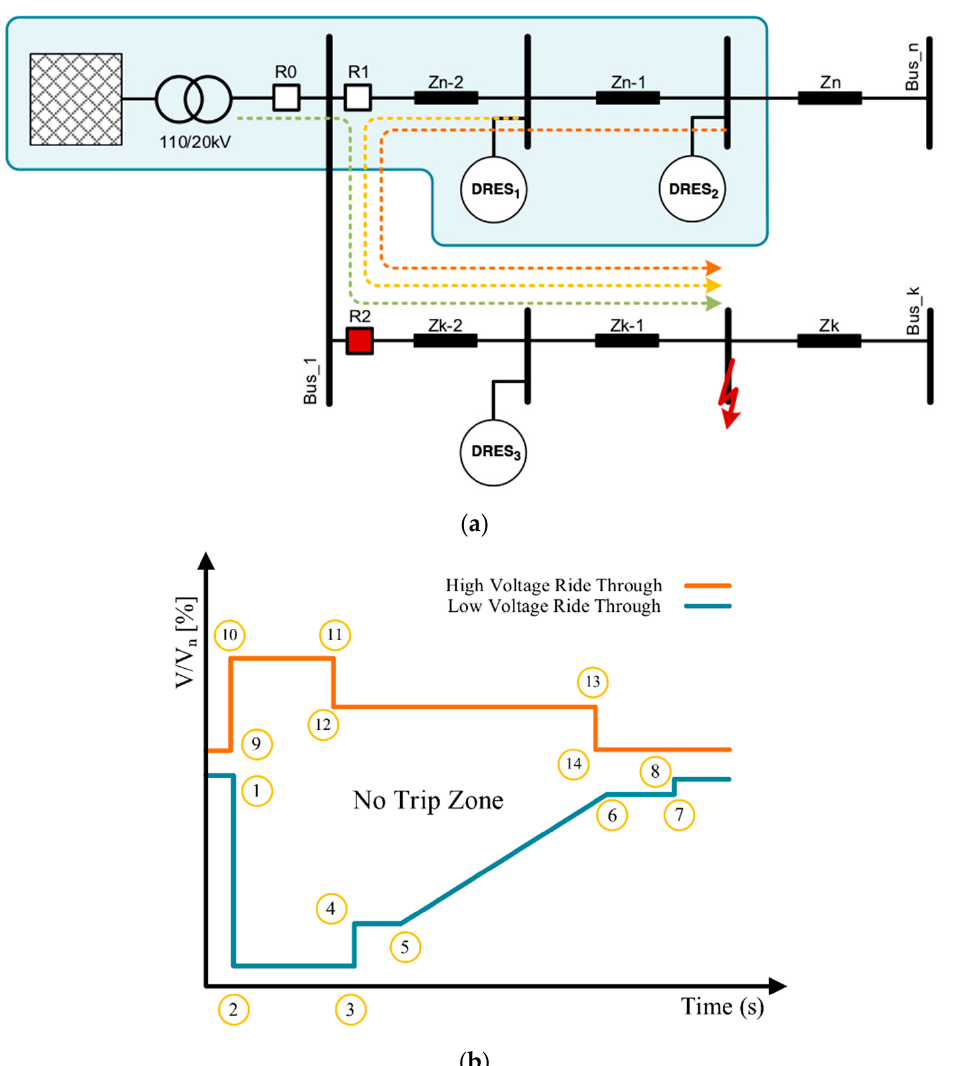
Figure 5. Illustrative example of DRES with FRT capability; ( a ) Possible cases for fault and DRES location in the two-feeder benchmark network; ( b ) generic FRT curve [97].